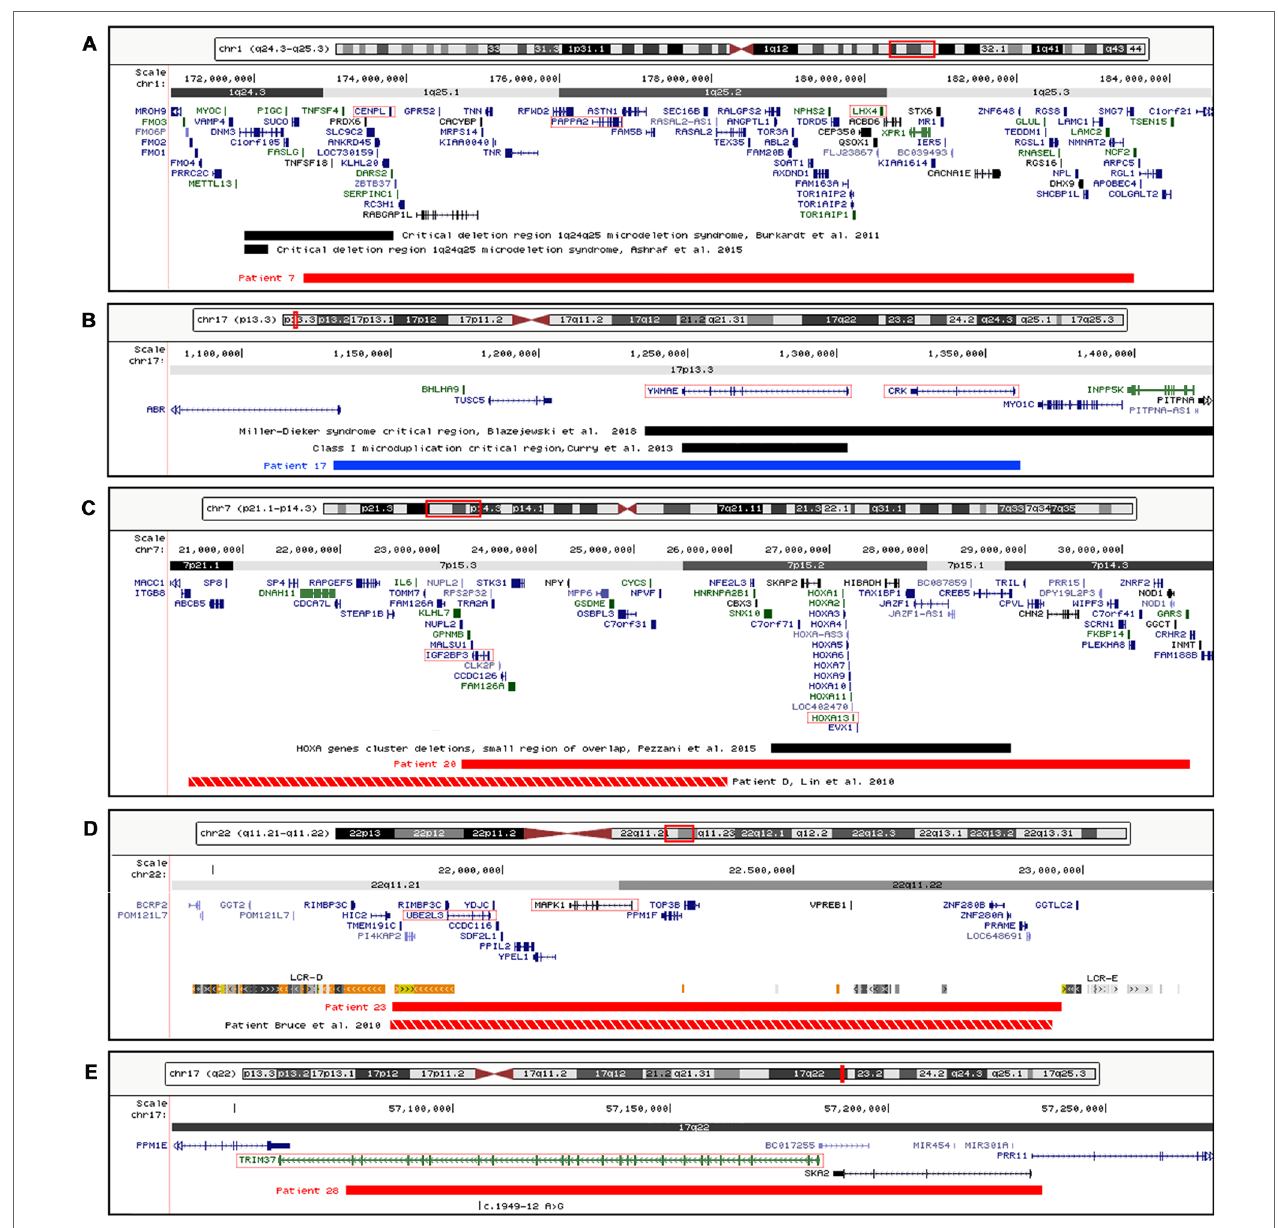
FIGURE 1 | Physical map of the genomic regions containing the pathogenic CNVs identified by array CGH. (A) 1q24.3-q25-5 region showing the deletion detected in patient 7. (B) 17p13.3 region showing the duplication detected in patient 17. (C) 7p21.1-p14.3 region showing the deletion detected in patient 20. (D) 22q11.21-q11.22 region showing the deletion detected in patient 23 and the low copy repeats (LCR-E and LCR-D) surrounding the deletion bkps. (E) 17q22 region showing the deletion and the mutation c.1949-12 A > G involving TRIM37 gene detected in patient 28. The RefSeq genes are depicted in dark blue, and the OMIM disease genes in green; the disease critical regions are indicated by black bars, the deletions by red bars, the duplications by blue bars, the deletions of previously reported SRS patients by red-white bars, and the candidate genes by red boxes. The images are a modification of a version obtained from the UCSC Genome Browser (human genome assembly GRCh37/hg19). CNVs, copy number variants; CGH, comparative genomic hybridization; OMIM, Online Mendelian Inheritance in Man; SRS, Silver–Russell syndrome; UCSC, University of California Santa